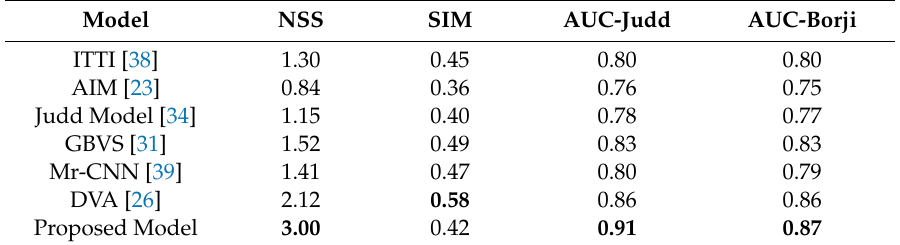
Table 1. Comparison of the quantitative scores of several models for the TORONTO [31] dataset.